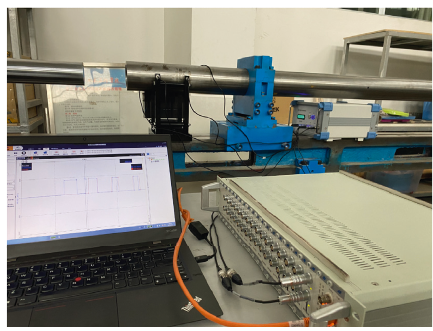
Figure 3: Electric speedometer.